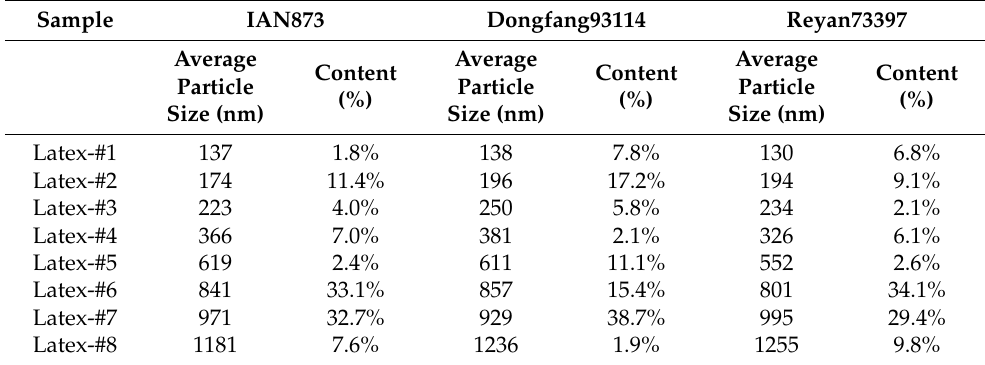
Figure 1. Particle size distribution of FNRL and separated latexes from different Hevea brasiliensis clones (arrows indicate the average particle size of the corresponding particle size distribution curve): ( a ) IAN873; ( b ) Dongfang93114; ( c ) Reyan73397. Table 1. Average particle size of separated latexes from different Hevea brasiliensis clones.